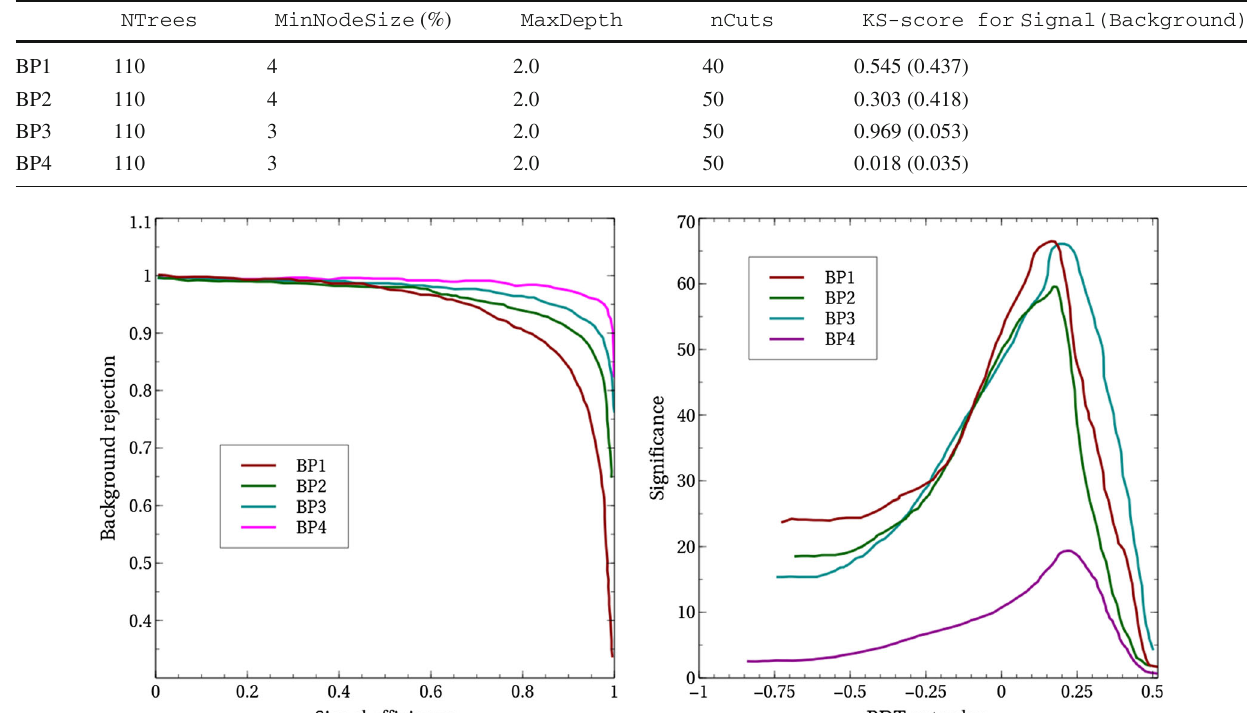
Table 7 Tuned BDT parameters for BP1, BP2, BP3 and BP4 for the 2 (cid:10) + E / T channel